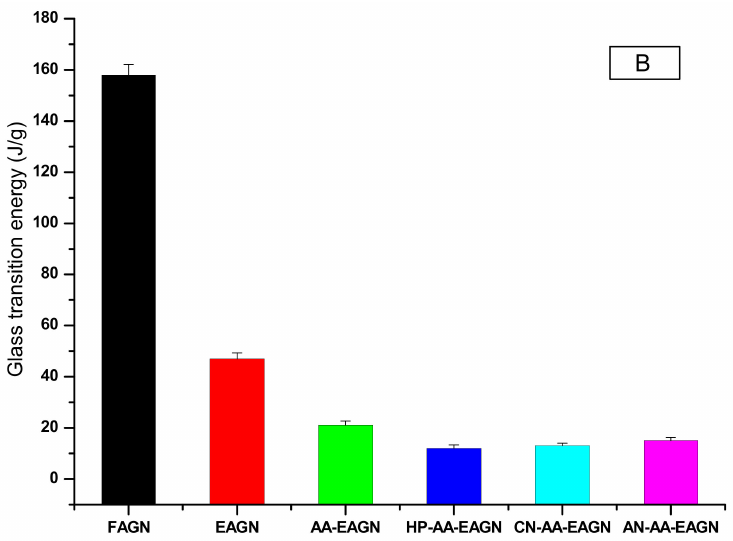
Figure 4. Glass transition temperature ( A ) and glass transition energy ( B ) of the AGNC formulation.